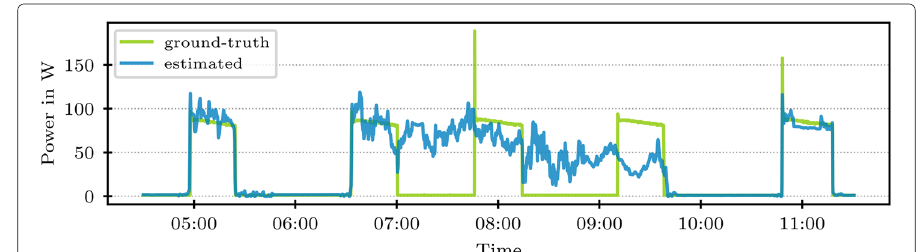
Fig. 10 An excerpt of estimates provided by S2P for the fridge in REFIT house 2 when applied to the real aggregate